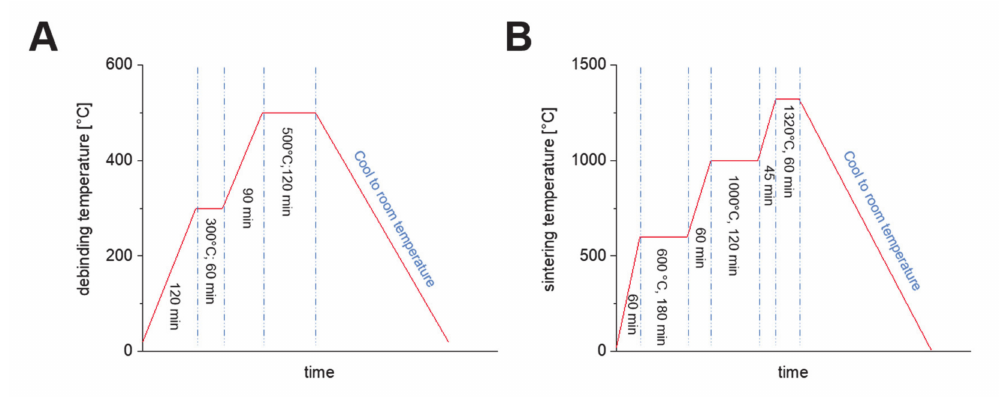
Figure3. Applicateddebinding,( A )andsinteringcurve,( B )for3DprintedBaTiO 3 /